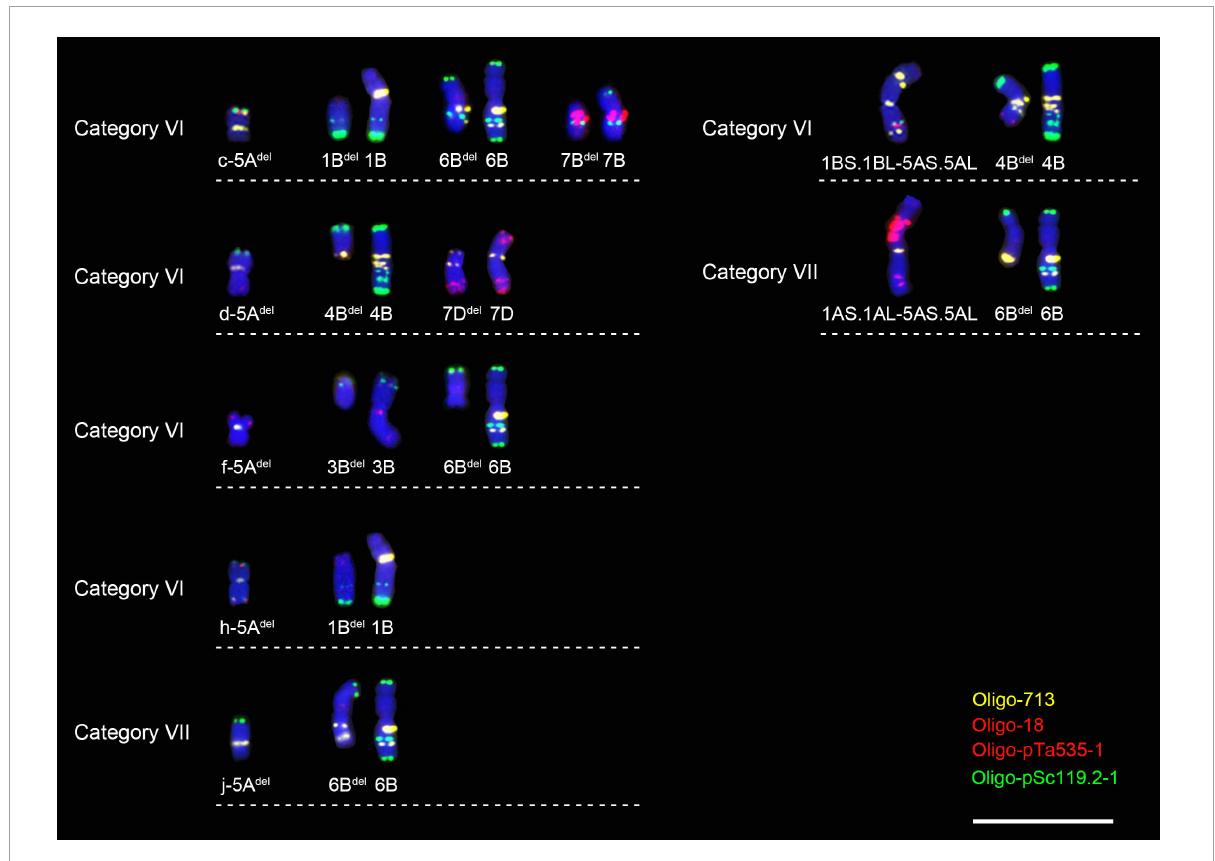
FIGURE7 Other broken chromosomes in the cells with broken 5A chromosome or 5A translocation. Scale bar, 20 µ